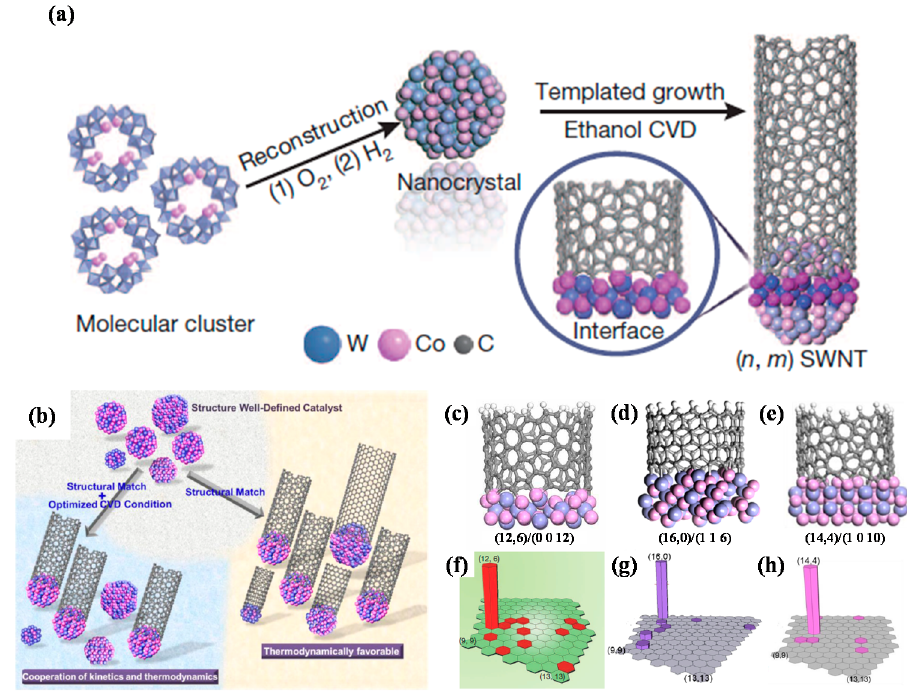
Figure 14. ( a ) Preparation of the W-Co nanocrystal catalysts and the templated growth of a SWCNT with specific chiral indices ( n , m ) [168]. ( b ) Schematic illustration of cooperative functions of